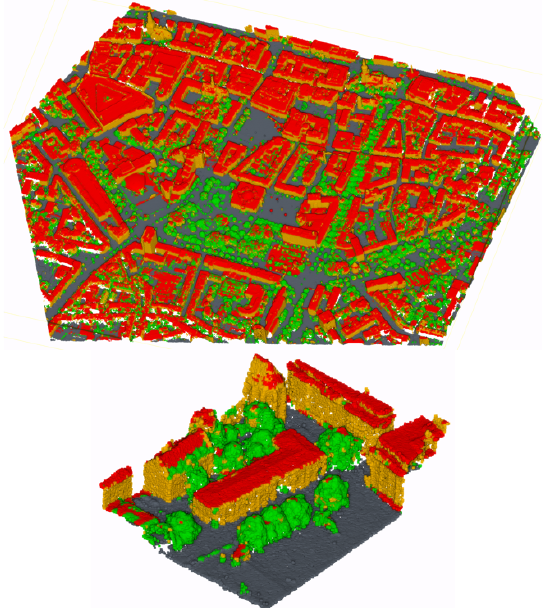
Figure 10. 2D CNN classification results for Dortmund: entire city centre (top) and evaluation part (bottom).